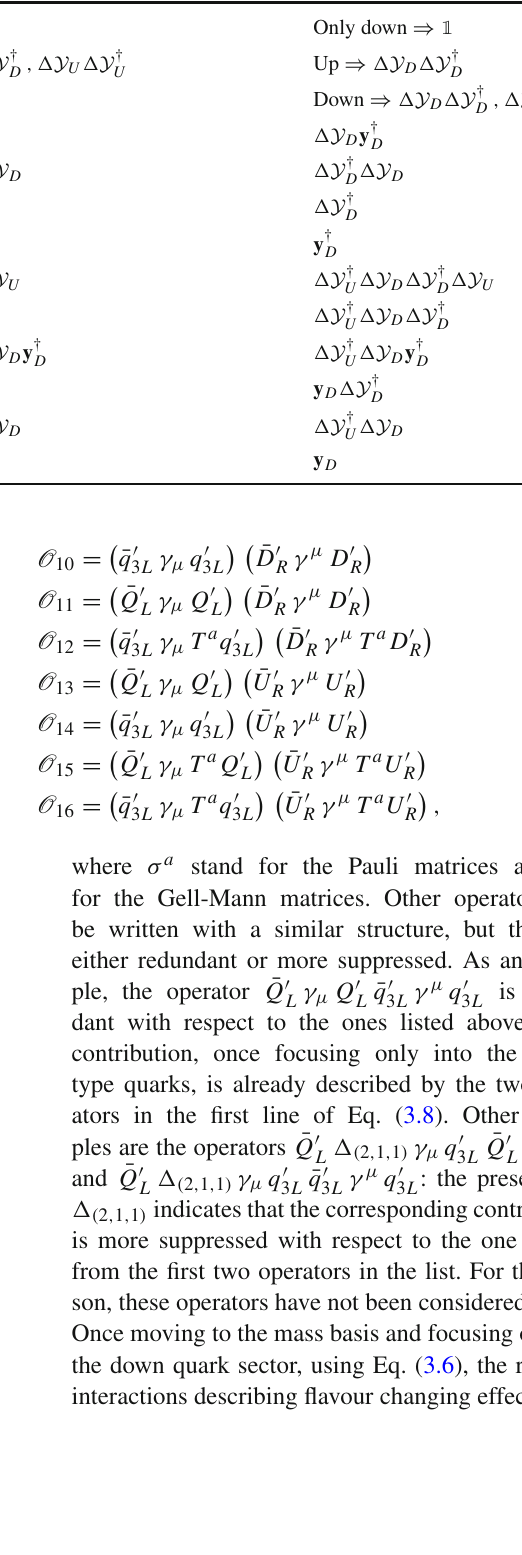
Leading contribution Leading FC